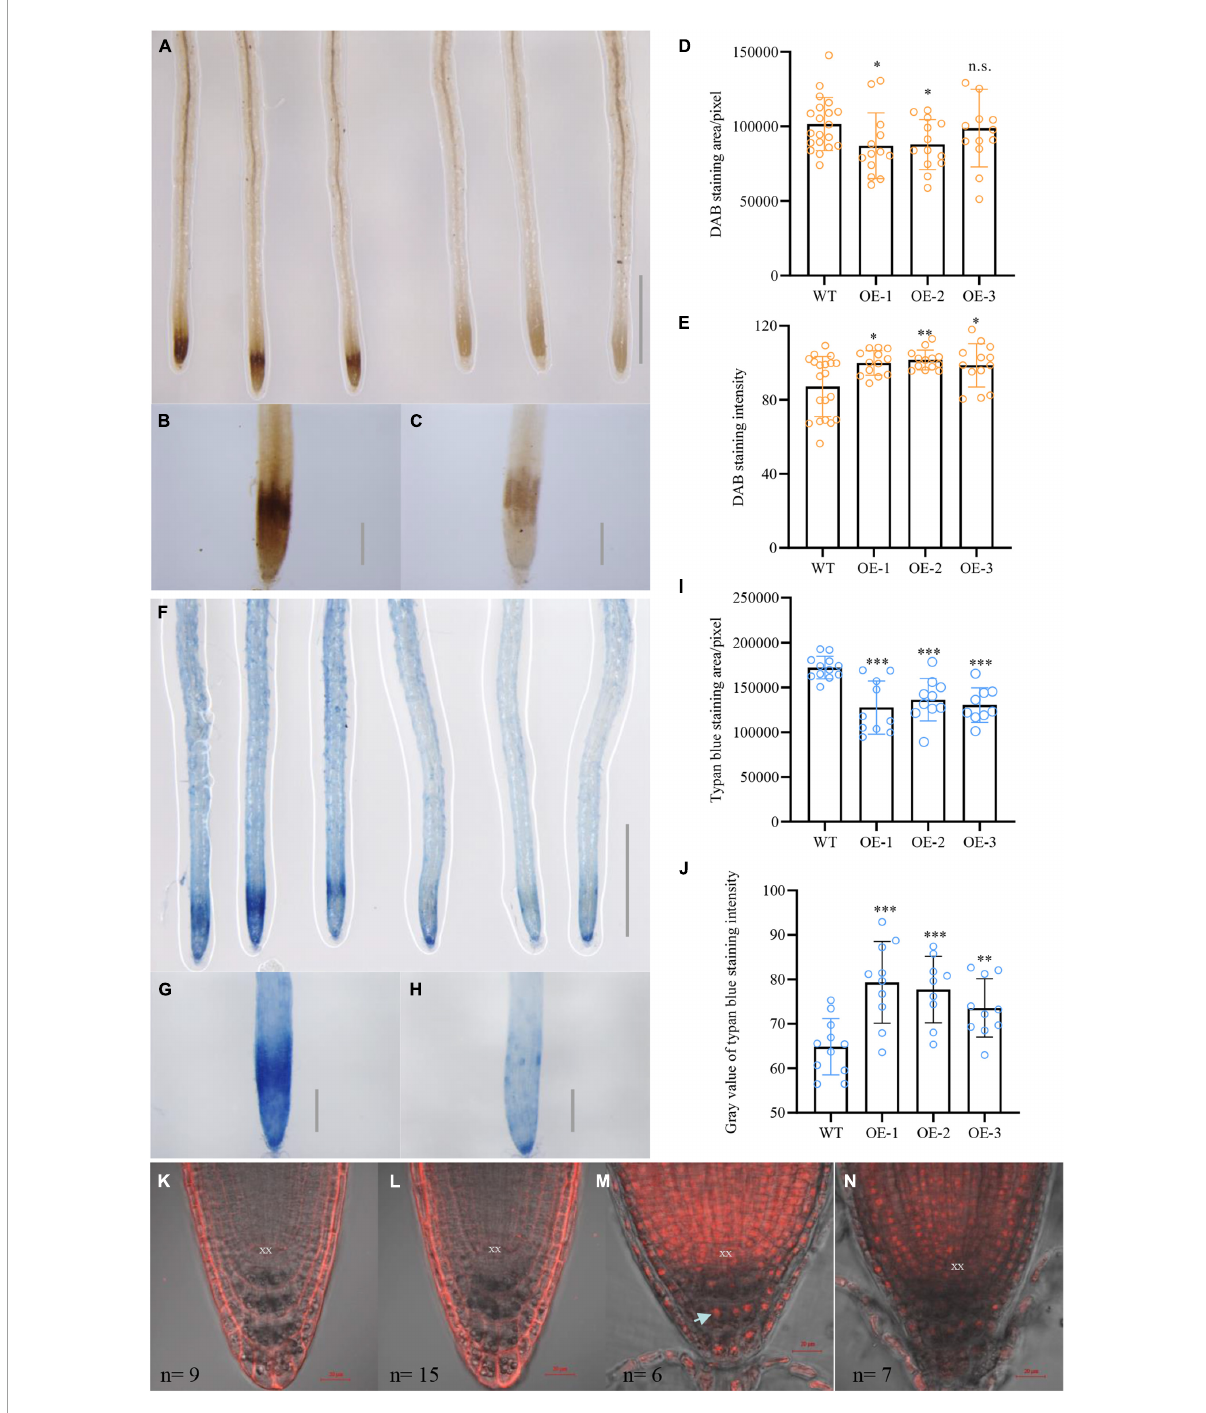
FIGURE8 NbCIPK25 overexpression reduces H 2 O 2 content and cell damage caused by salt stress. (A–C) DAB staining for H 2 O 2 of WT (left three roots in A and B ) and transgenic seedling roots (right three roots in A and C ) treated with 100 mM NaCl for 2 days, scale bar in A: 0.1 cm; scale bar in B; and C: 0.01 cm. (D,E) Statistical analysis of DAB staining area (D) and intensity (E) for roots in (B) and (C) , data represent the means ± SD from three biological replicates. A t -test was used to determine statistical significance. “ ∗ ” p < 0.05, “ ∗∗ ” p < 0.01, n.s.: not significant. (F–H) Trypan blue staining for cell damage in WT (left three roots in F and G ) and transgenic seedling roots (right three roots in F and H ) treated with 100 mM NaCl for 2 days; scale bar in f: 0.1 cm; scale bar in g and h: 0.01 cm. (I–J) Statistical analysis of trypan blue staining area (I) and gray value (J) for roots in (G,H) . (K–N) PI staining of the 5-day-old WT and transgenic seedlings grown for 24 h in the absence of salt (panels K and I , respectively) or in the presence of 100 mM NaCl ( M and N , respectively). The arrowhead indicates a nucleus and n indicates the number of observed plants. “ ∗ ” p < 0.05, “ ∗∗ ” p < 0.01, “ ∗∗∗ ” p < 0.001, n.s.: no significant difference as determined from a t